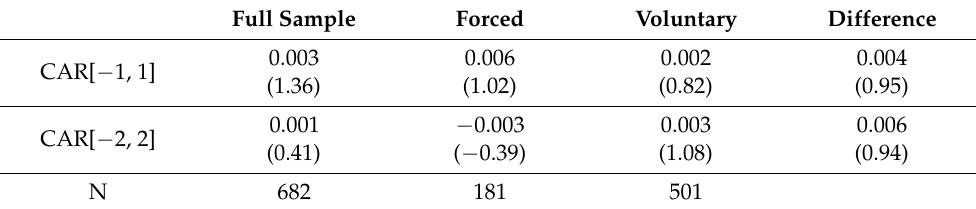
Table 2. Price reaction to CEO